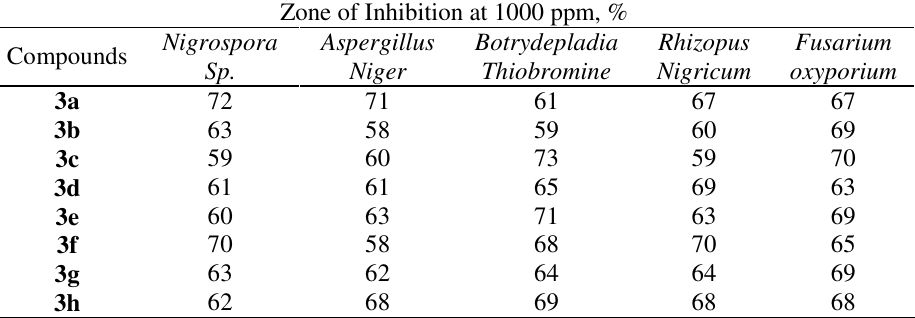
Table 5. Antifungal Activity of Compounds